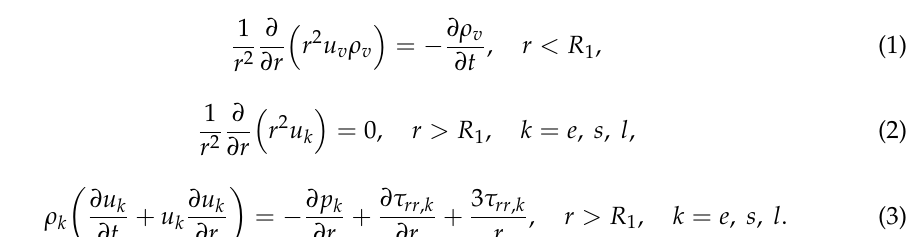
Figure 1. Scheme of a droplet: v —vapor, e —liquid phase, s —shell and l —carrier liquid. The equations of continuity and momentum in a spherical coordinate system in the presence of central symmetry and assuming the incompressibility of liquid phases and shell are written as